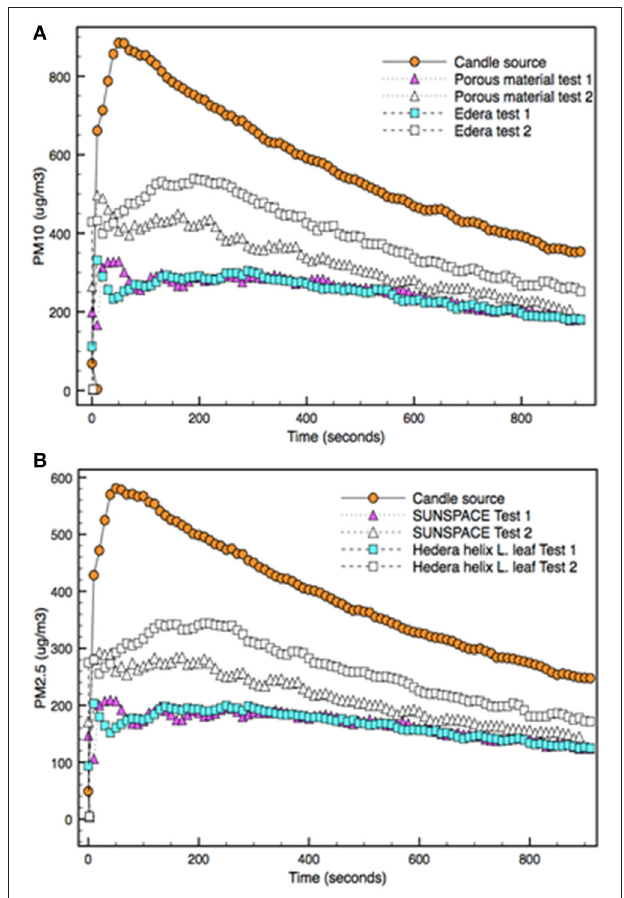
FIGURE 4 | PM 10 (A) and PM 2.5 (B) concentrations emitted by the candle burning source in the experimental box and detected when a trapping